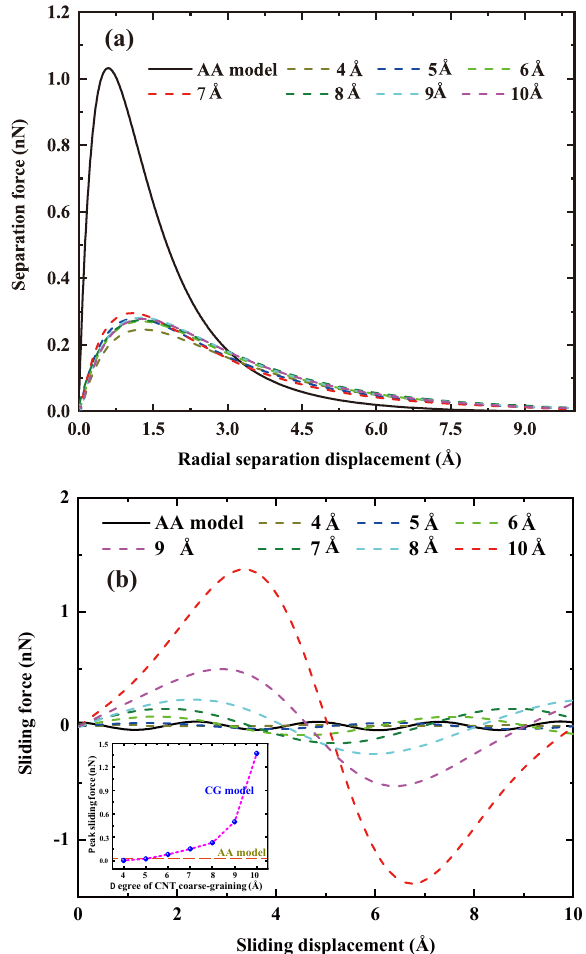
Figure 5. Force-separation curves of the “monomeric separation response” for the AA and CG interface models, ( a ) radial opening mode, and ( b ) axial sliding